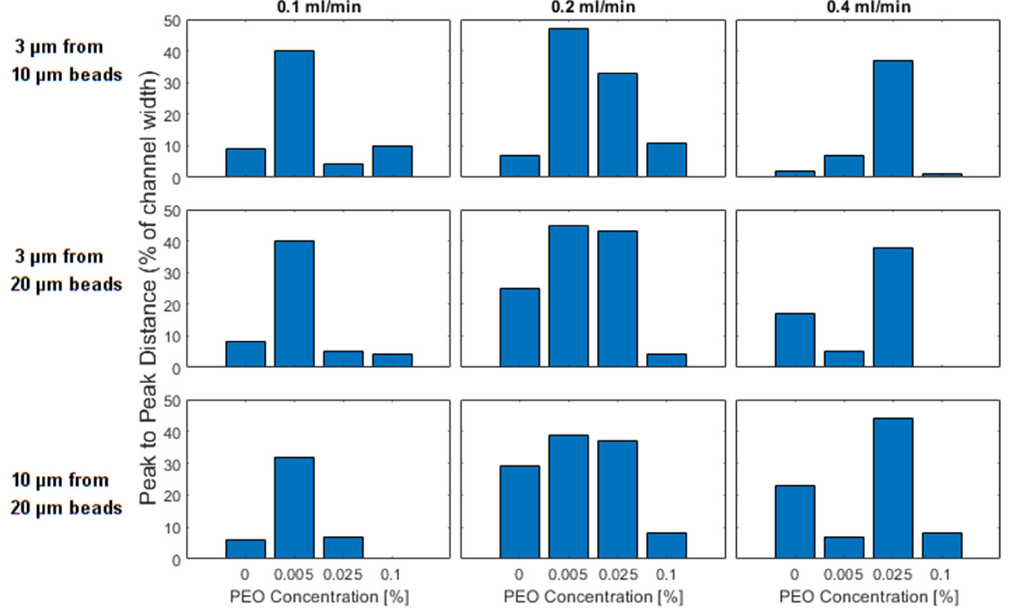
Figure 9. Peak to peak distance as a percentage of the channel width) between the peaks formed in the focusing of differently sized particles. In the first row, 3 and 10 μ m beads are compared, in the second row 3 and 20 μ m beads are compared and in the third row 10 and 20 μ m beads are compared. The columns represent the flow rates of 0.1, 0.2, and 0.4 mL/min. The individual bars within a plot represent different PEO concentrations which increase from left to right.